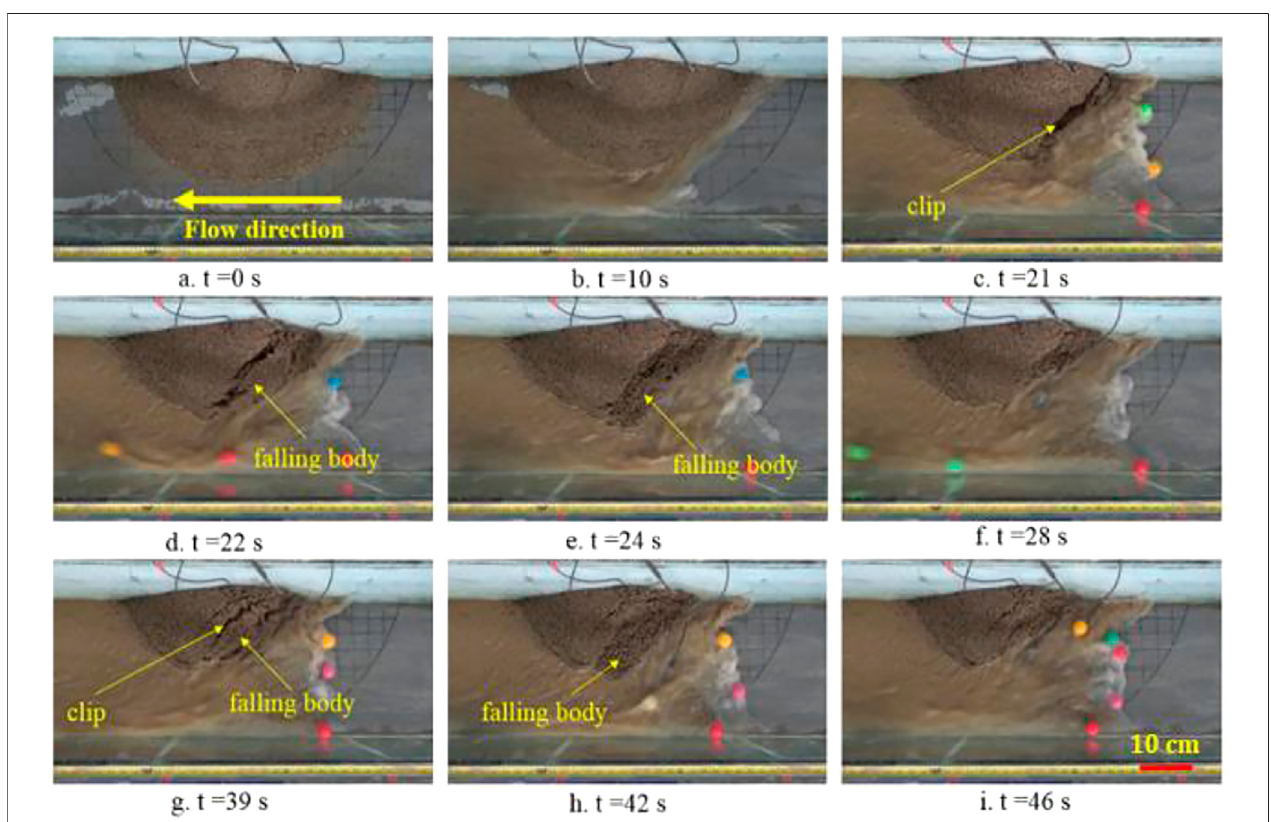
FIGURE 3 | Typical features of the fl ow and deposit body during experiment E-1.